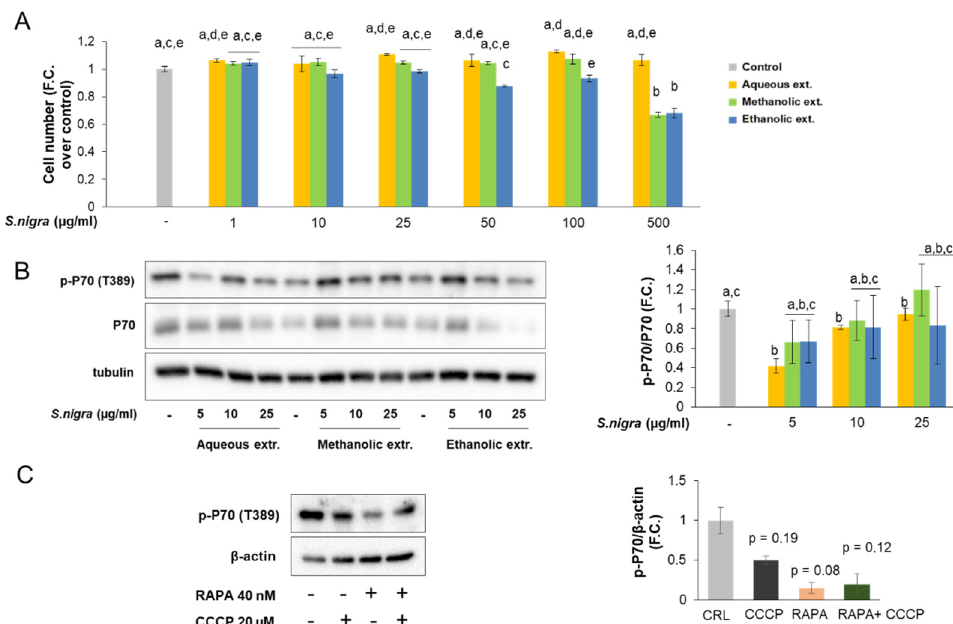
Figure 2. Effect of aqueous, methanolic, and ethanolic extracts from S. nigra flowers on cell number ( A ) and mTORC1 signaling ( B ) in SH-SY5Y cells. ( C ) Western blots from SH-SY5Y cells treated with the mitochondrial uncoupler CCCP (20 µM) for 2 h in the presence or absence of 40 nM of rapamycin for 24 h with densitometric quantification of p-p70. We used rapamycin (RAPA) as a positive control to inhibit mTORC1 signaling. Values are means ± SD. n = 3. Values are expressed as a fold change (F.C.) relative to control condition. Different letters indicate statistically significant differences ( p < 0.05) among groups. In panel C, p values are indicated compared to the indicated control.